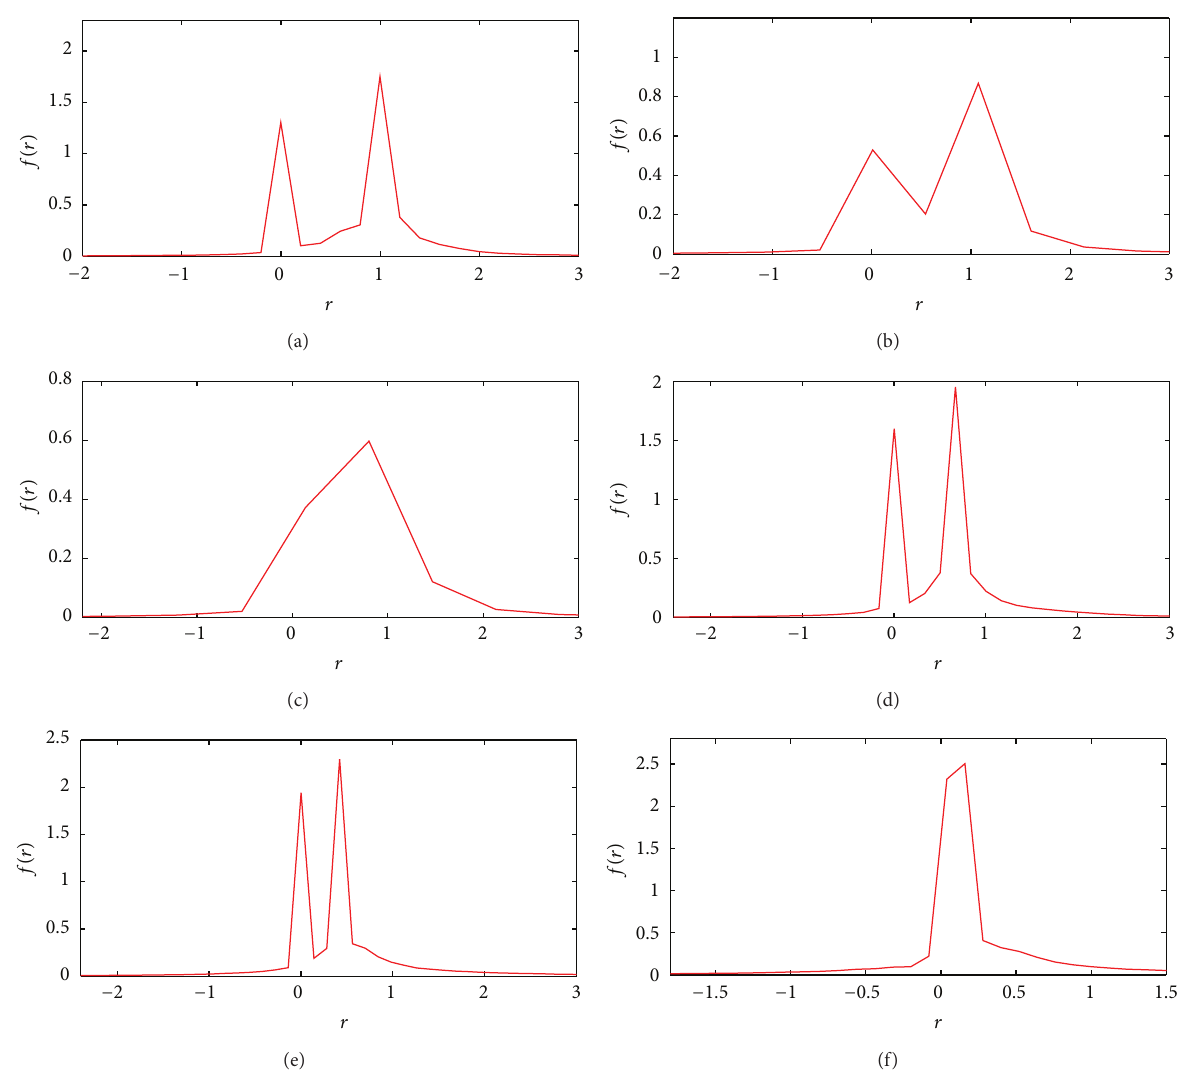
and noise scales. The distributions of residuals for the combined patches shown in Figure 8 for V 1 − V 2 = 1 and different noise scales including (a) 𝜎 𝑒 = 0.14 (separable), (b) 𝜎 𝑒 = 0.24 (critical), and (c) 𝜎 𝑒 = 0.45 (inseparable), as well as different relative velocities for 𝜎 𝑒 = 0.1 including